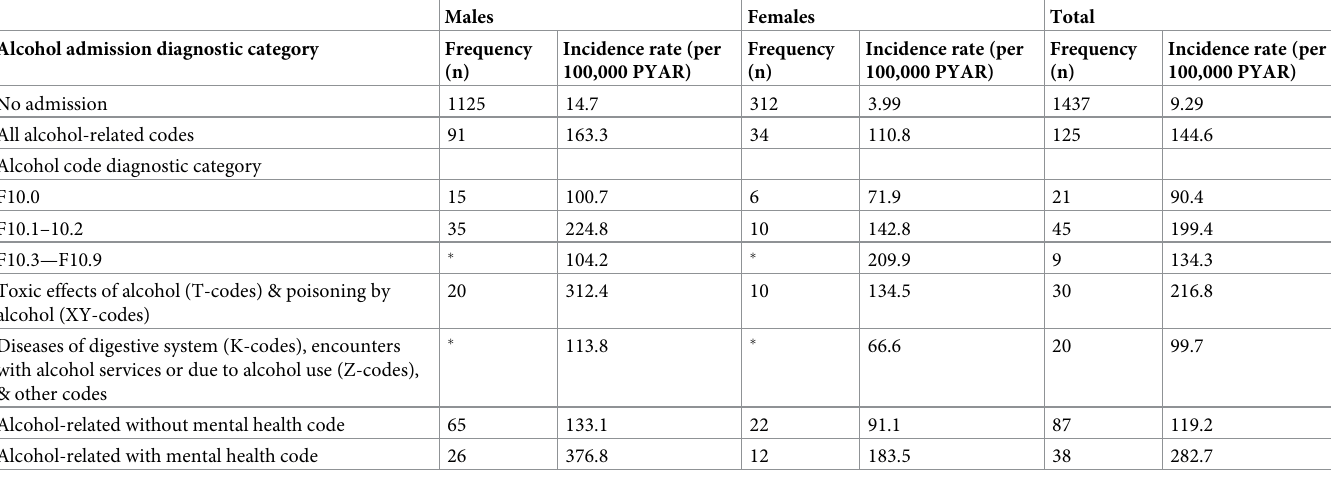
Table 2. Frequency and incidence rates of death from suicide by alcohol admission